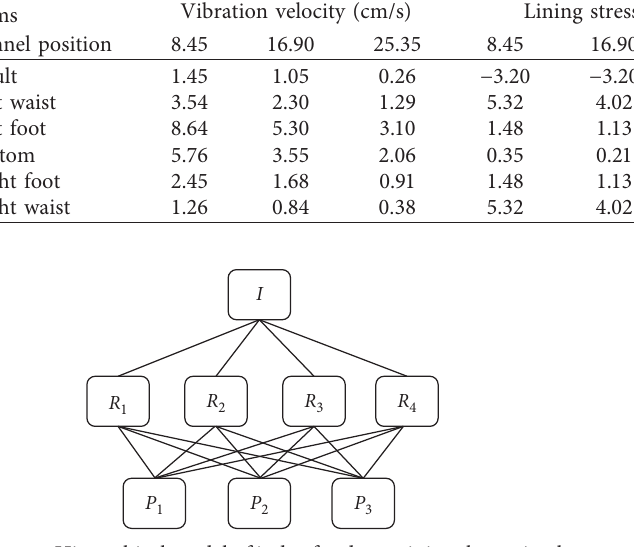
Figure 7: Hierarchical model of index for determining the optimal indicator of dynamic